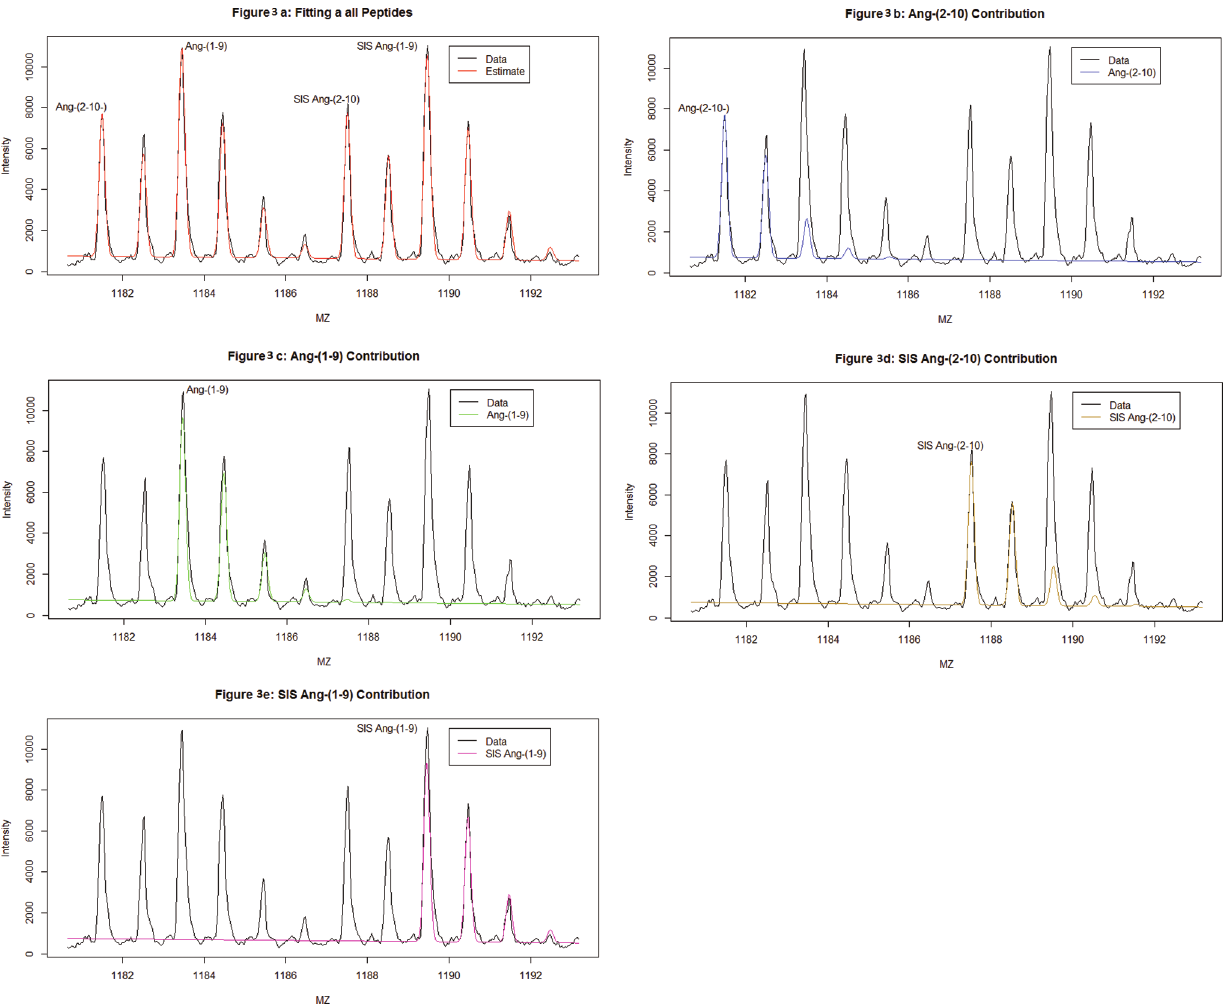
Figure 3. A MALDI-TOF mass spectrum of a known ratio of 1:1:1:1 peptides consisting of 300 nM Ang-(2–10), Ang-(1–9), SIS-Ang-(2– 10) and SIS-Ang-(1–9). The spectrum has been fit using GMM and the figure shows how each estimated peptides contributes to the whole spectrum. Since all peptides are estimated simultaneously, each peptide is presented here separately to illustrate the individual contribution of each peptide to the spectrum as a whole. (A) Figure 3a shows the entire estimation as a whole, preformed as a single fit to a single cluster of four overlapping peptides. The data is shown in black with the estimated peaks superimposed in red. (B) Figure 3b shows the estimated contribution of Ang-(2–10) to the spectra superimposed in blue. (C) Figure 3c shows the estimated contribution of Ang-(1–9) to the spectra superimposed in green. (D) Figure 3d shows the estimated contribution of SIS-Ang-(2–10) to the spectra superimposed in dark yellow. (E) Figure 3e shows the estimated contribution of SIS-Ang-(1–9) to the spectra superimposed in dark purple.